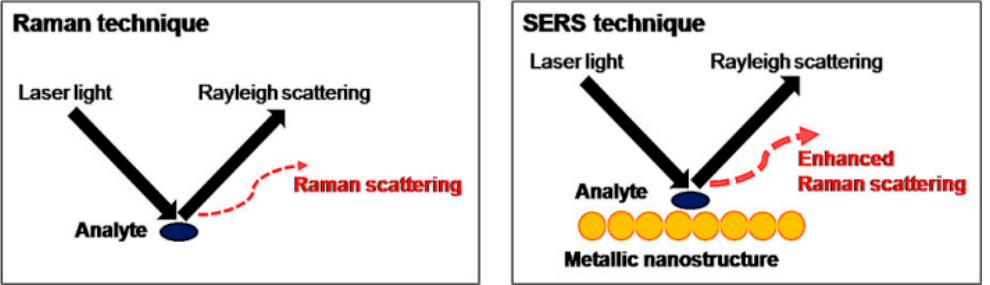
Figure 27. The principles behind Raman and Surface-Enhanced Raman Scattering (SERS) techniques (adapted with permission from Reference [107], copyright Institute of Food Technologists).